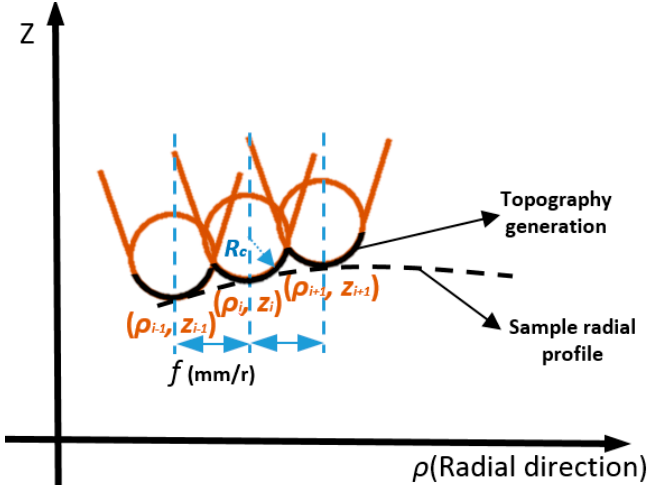
Figure 12. Schematic diagram of profile topography generation.